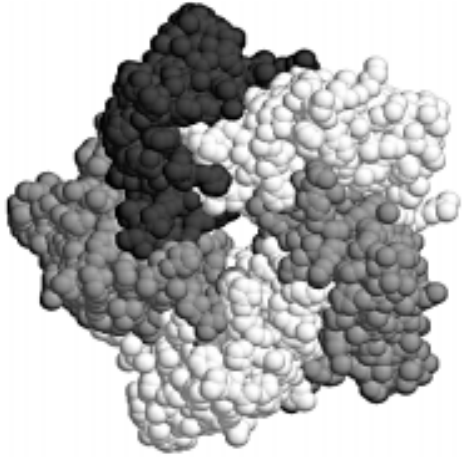
Figure 2 - Space-fill model of the pentameric Brucella lumazine